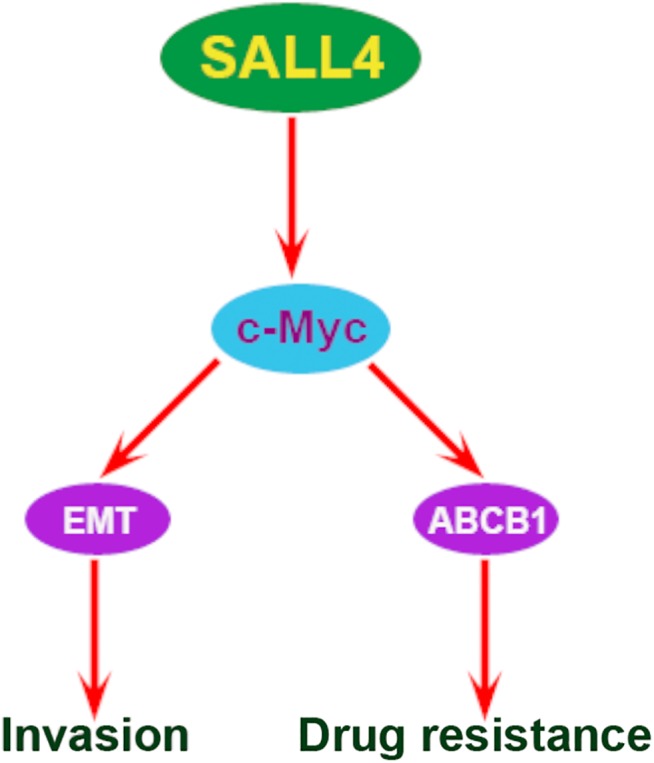
Schematic diagram of the c-Myc-mediated SALL4-induced EMT and chemoresistance signaling pathways in endometrial cancer cells.SALL4 induced EMT and ABCB1 expression, which subsequently contributed to invasion and chemoresistance in endometrial cancer cells. ABCB1 was critical to SALL4-induced chemoresistance. In addition, SALL4 also upregulated c-Myc expression, which was required for SALL4-induced EMT and ABCB1 expression. In summary, SALL4-induced EMT and drug resistance through the activation of c-Myc in endometrial cancer.